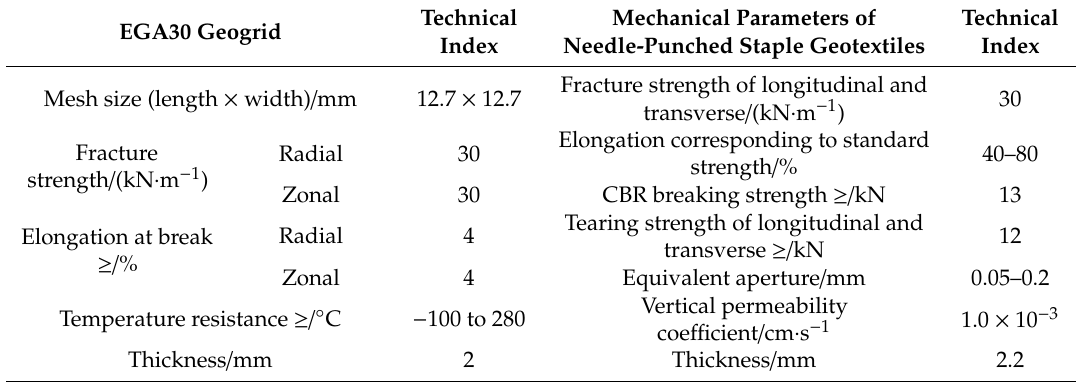
Table 1. Technology parameters of geosynthetics.